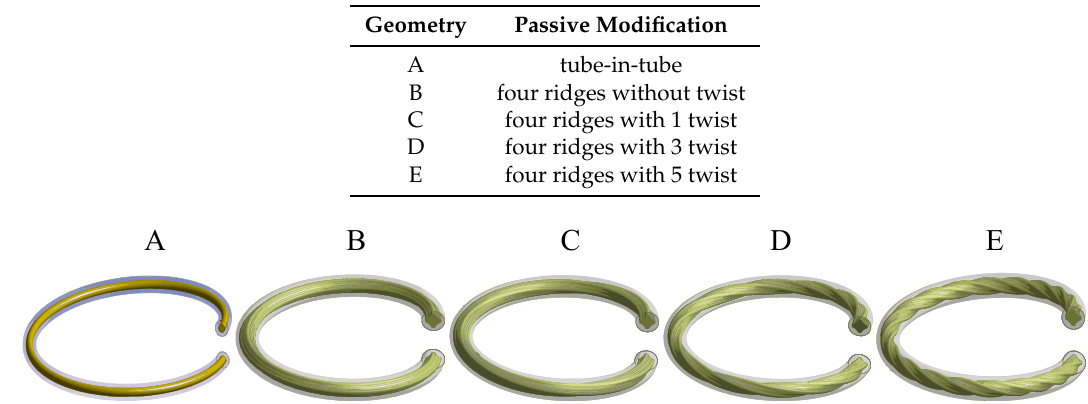
Figure 1. Simulated control volumes: external and internal flows with the second passive technique evolution. A: tube-in-tube. B: four ridges without twist. C: four ridges with 1 twist. D: four ridges with 3 twist. E: four ridges with 5 twist.